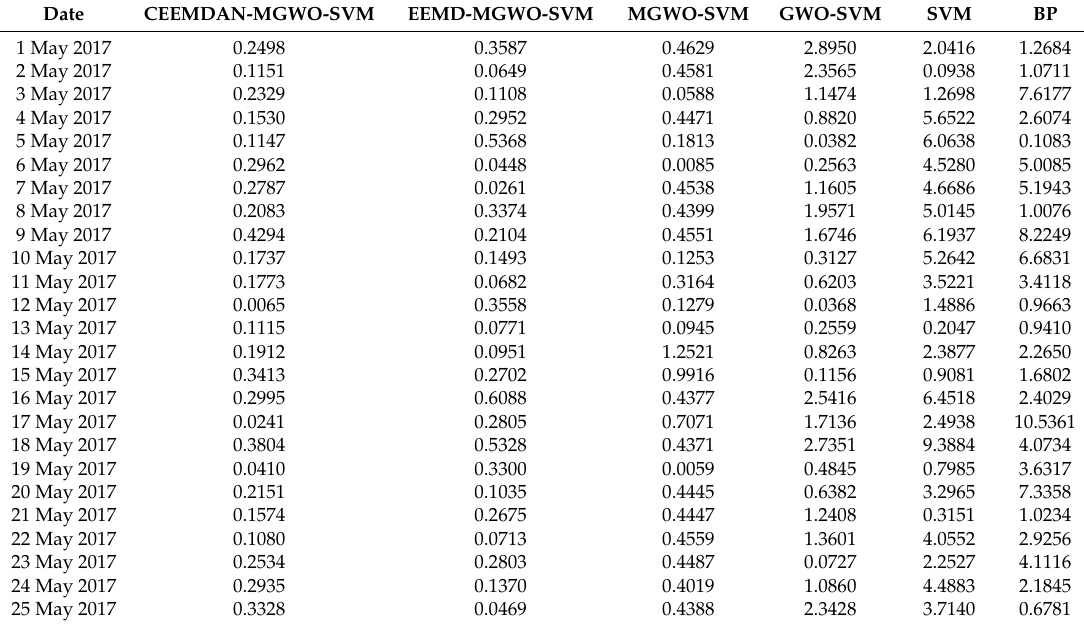
Table 4. The relative errors of the forecasting results for different models.